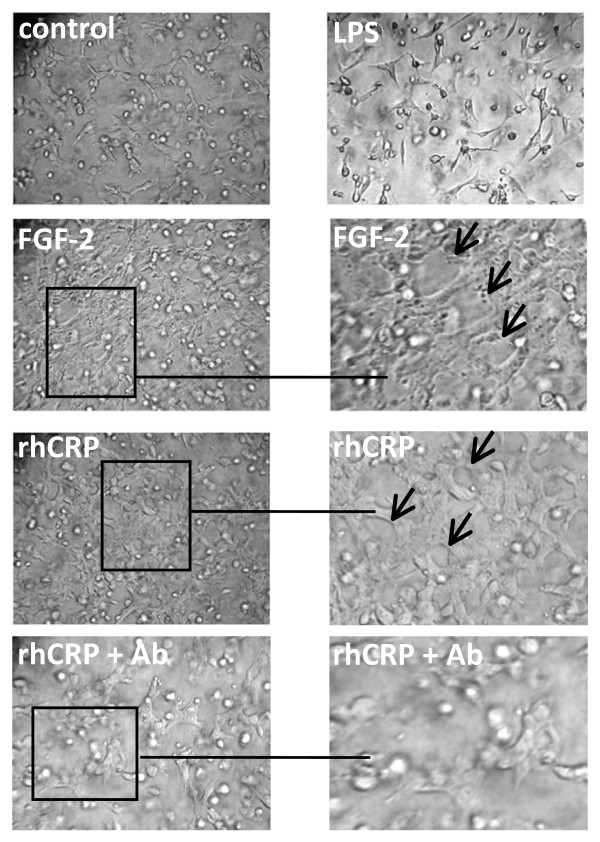
CRP induced tube-like structure formation in BAEC. Representative images from control cells and cells treated with 1 ng/ml LPS, FGF-2 (25 ng/ml), 1 μg/ml of detoxified CRP [CRPdt] or CRP + blocking antibody against CRP for 24 h are shown.